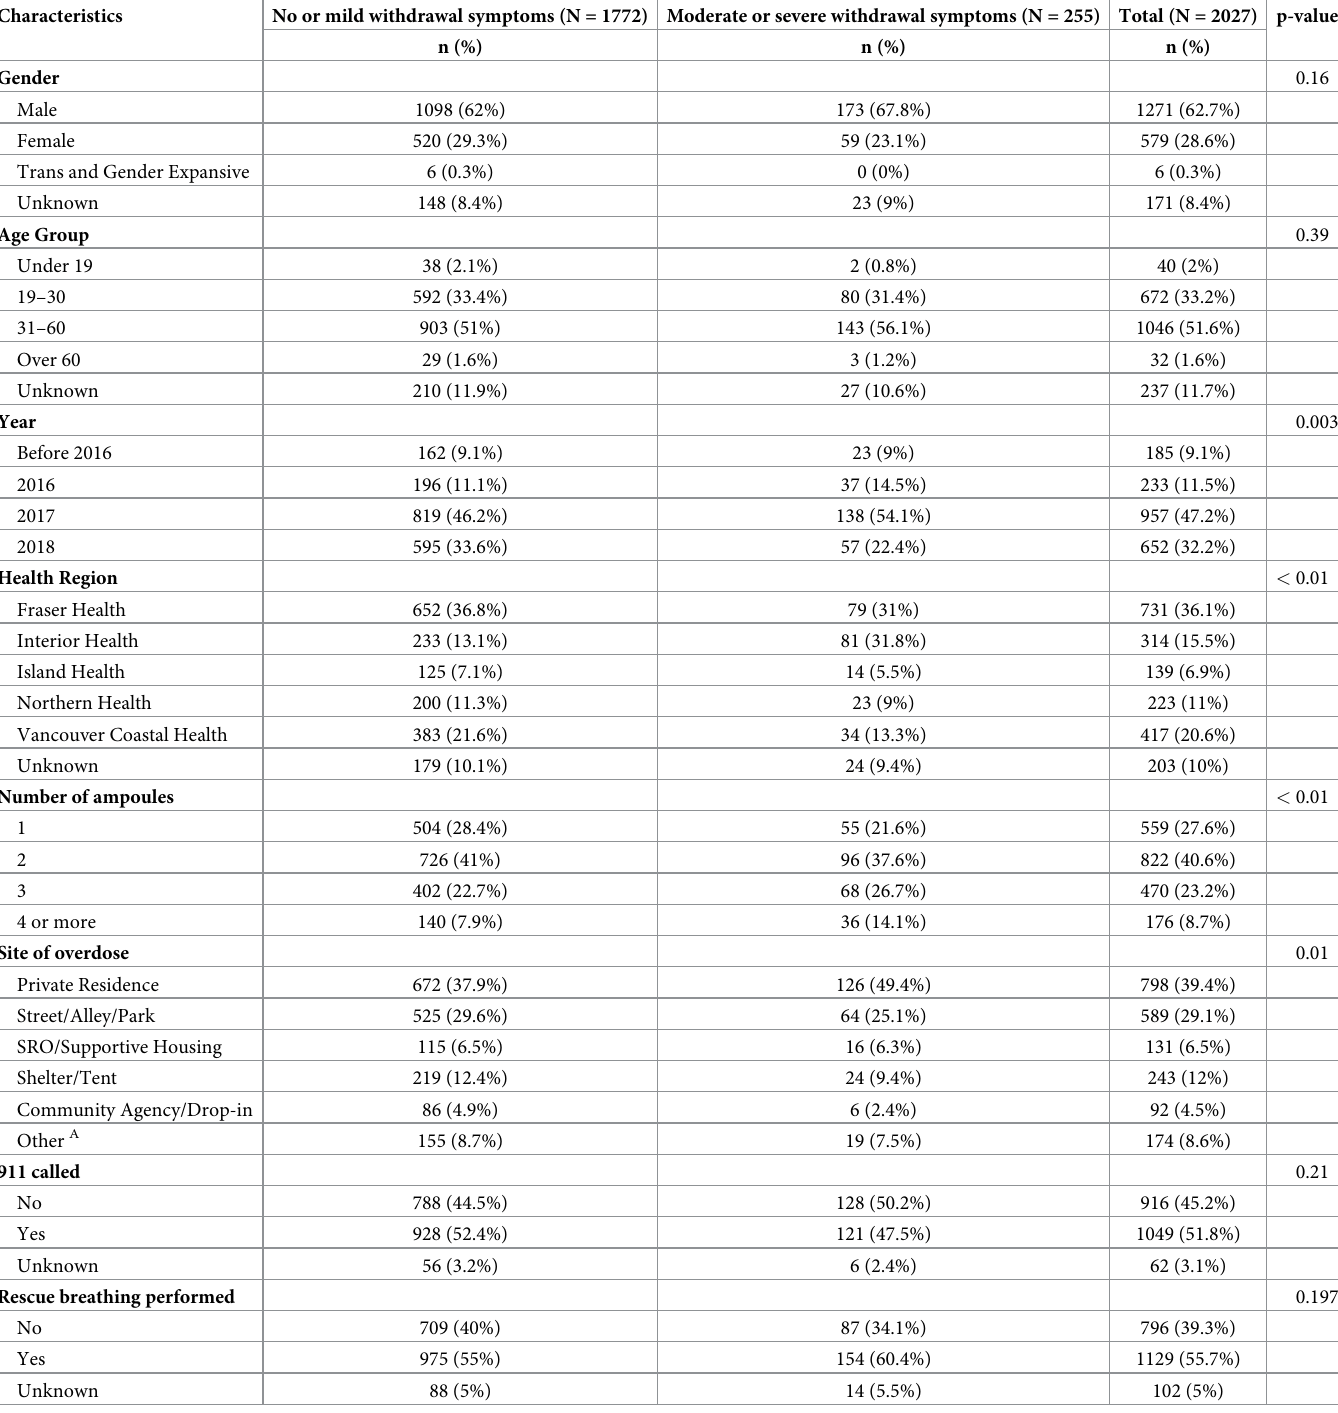
Table 2. Summary characteristics of Naloxone Administration Data, from program inception on August 31 2012 to December 31 2018.